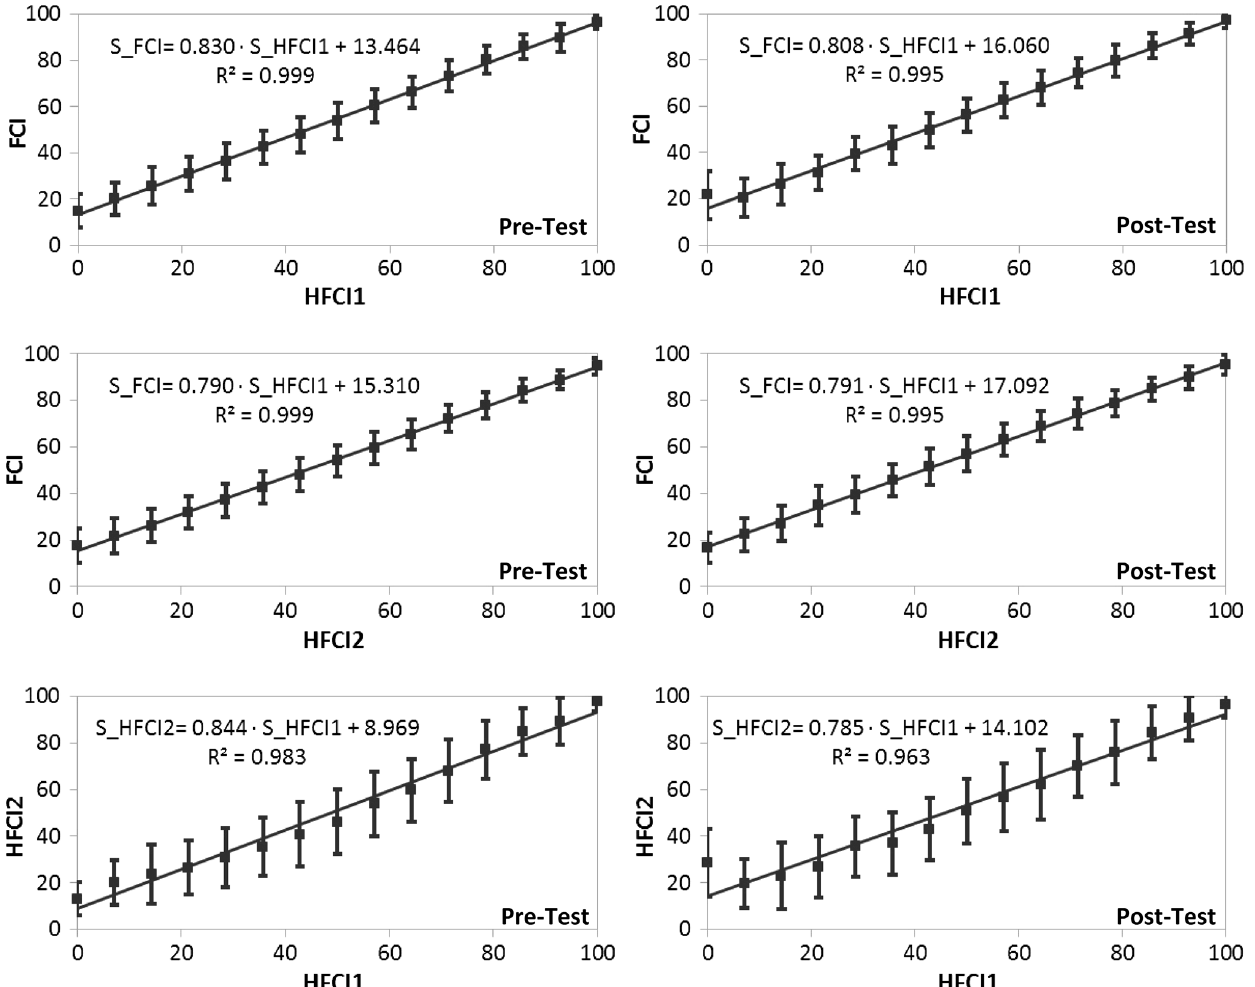
FIG. 2. Cross comparisons between FCI and the half-length tests. In each graph, there are 15 bins along the horizontal axis with an equal difference of 1 = 14 of the total score. A point on the graph represents the average score of the test described on the vertical axis from students having a score within a particular bin on the horizontal axis. The error bars are the standard error bar of each point gives the standard deviation of the average score of the test indicated on the vertical axis.